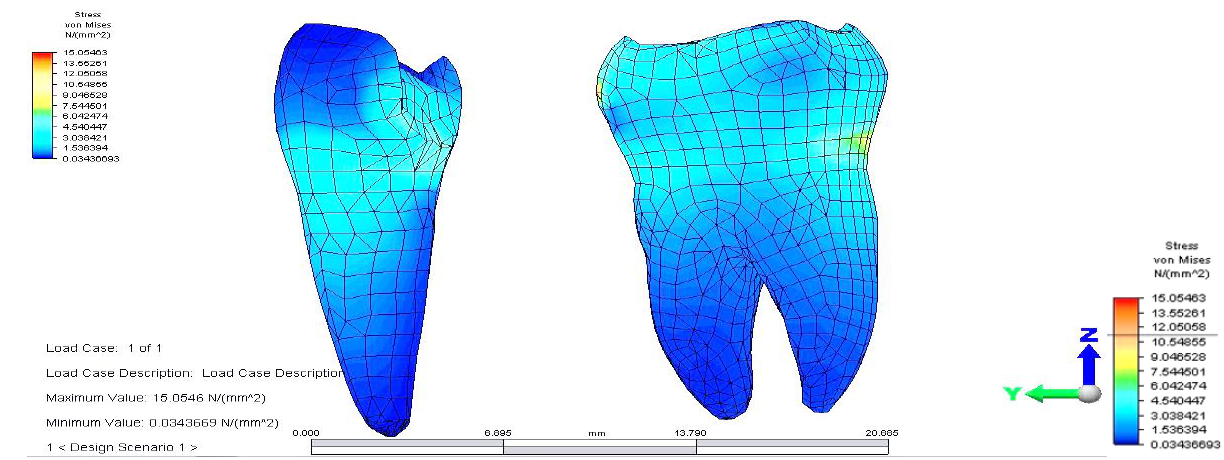
Figure 8. Tension distribution at abutments level in three directions: axonometric, right and left when the force is placed in the 3.6 area.